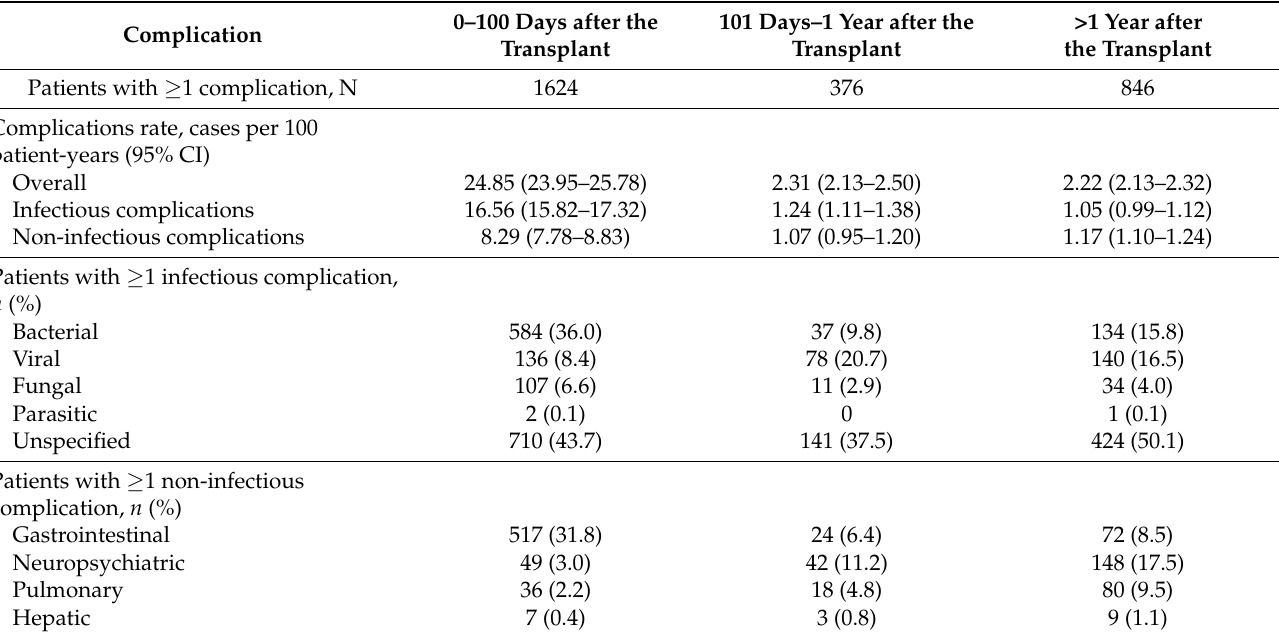
Table 2. Types, rates and number of complications occurred after the first autologous stem cell